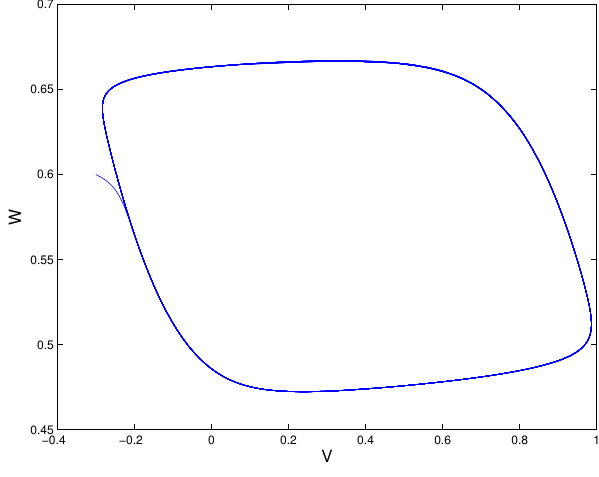
Figure 1. A limit cycle of the FHN